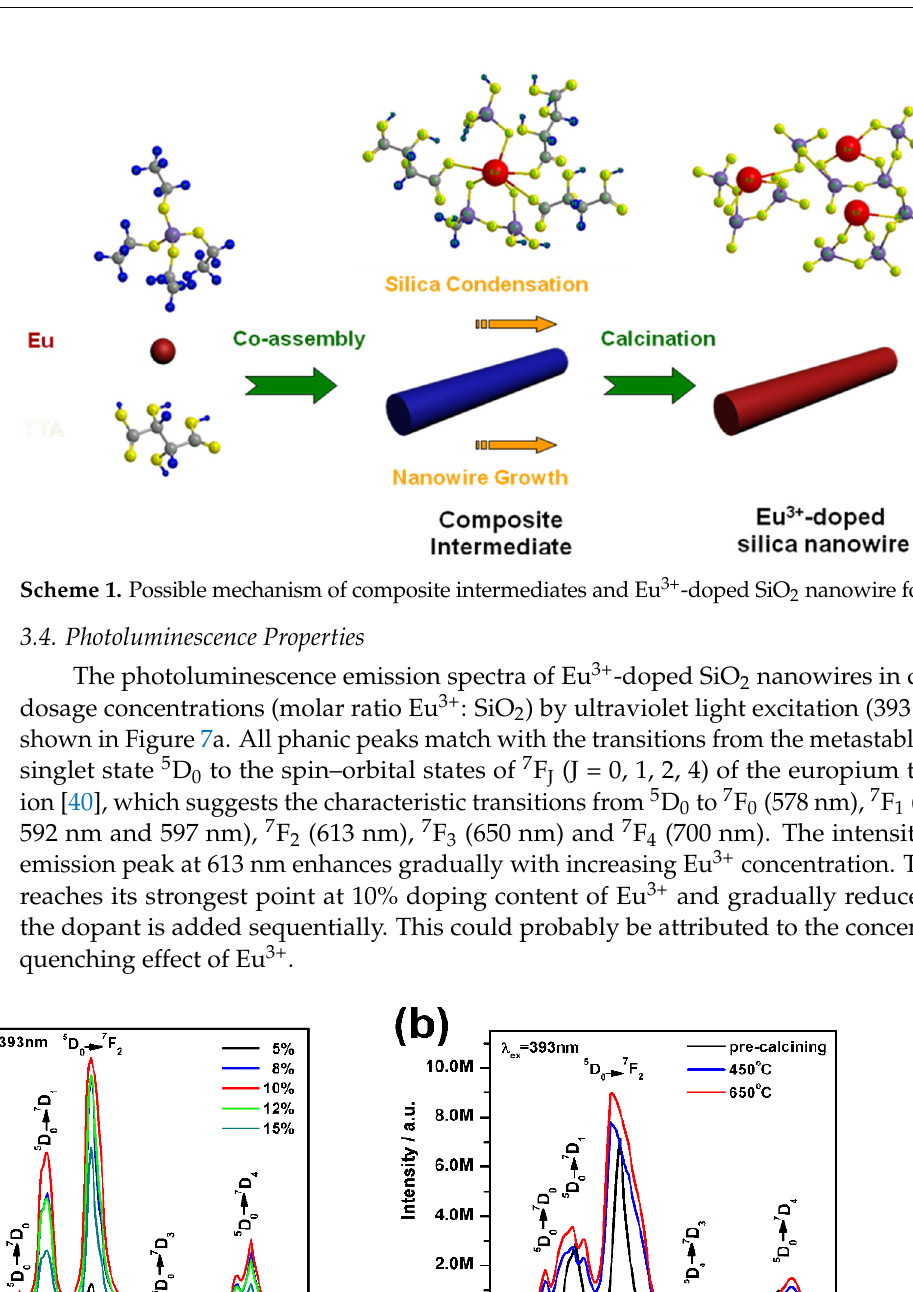
8 of 11 Figure 6. XPS spectra of ( a ) Eu 3d and ( b ) O 1s for Eu 3+ -doped SiO 2 nanowires in different doping content after calcination. According to the previous characterization results, a probable co-assembly mecha- nism model could be proposed for the synthesis of Eu 3+ -doped SiO 2 nanowires (as shown in Scheme 1), which contains three steps: (1) Eu ions coordinate with the TTA carboxyl by self-assembly in an aqueous solution to form nanofibers. The morphology, bound together by hydrogen bonding and metal coordination, should be stably maintained during the sol-gel reaction [38]; (2) Meanwhile, TEOS subsequently hydrolyzed into anionic oligo- meric silica species. These oligomeric groups are easily attracted to relatively acidic HC- OH groups in TTA due to electron withdrawing of the two carboxylates. These groups can act as “acids” to exchange an ethoxy group in TEOS, with the formation of triethox- ysilyl groups on the Eu-TTA complex chain. These triethoxysilyl groups may be con- densed upon increasing the pH, with NH 4 OH adding and making a three-dimensional